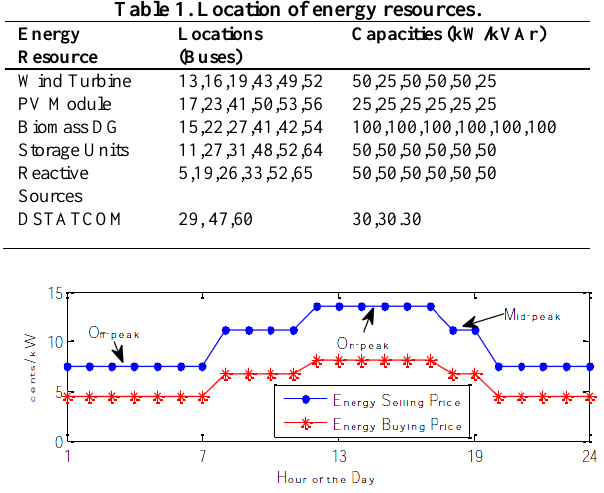
Figure 5. Hourly price of selling and buying electricity [18].